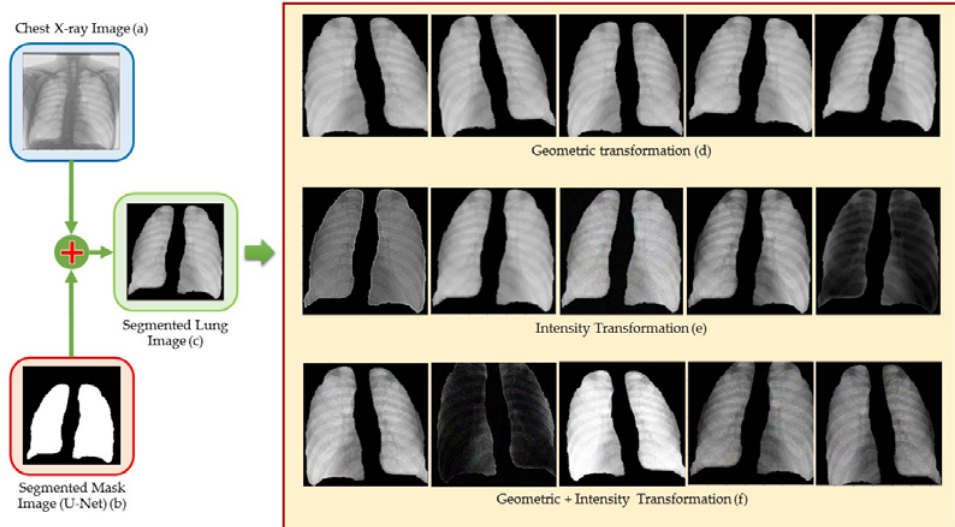
Figure 8. Image augmentation example (cid:5)